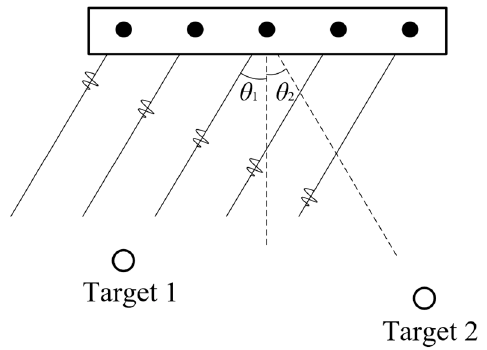
Figure 22. Illustration of steering during beamforming.